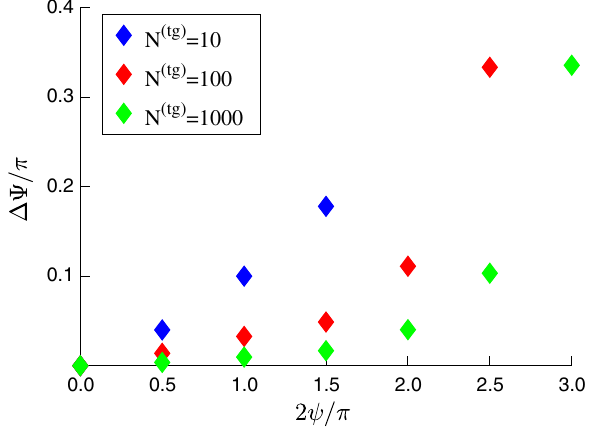
FIG. 7. The dependence of the phase-spread of the wake ( Δ Ψ ) on the initial phase distribution of the electrons, 2 ψ , for N ð tg Þ ¼ 10 (blue diamonds), N ð tg Þ ¼ 100 (red diamonds), and N ð tg Þ ¼ 1000 (green diamonds). Here the phase-spread of the wake is defined as the standard deviation of the wake phase at β cT ¼ 12 . 7 cm for 500 numerical simulations ( “ experiments ”